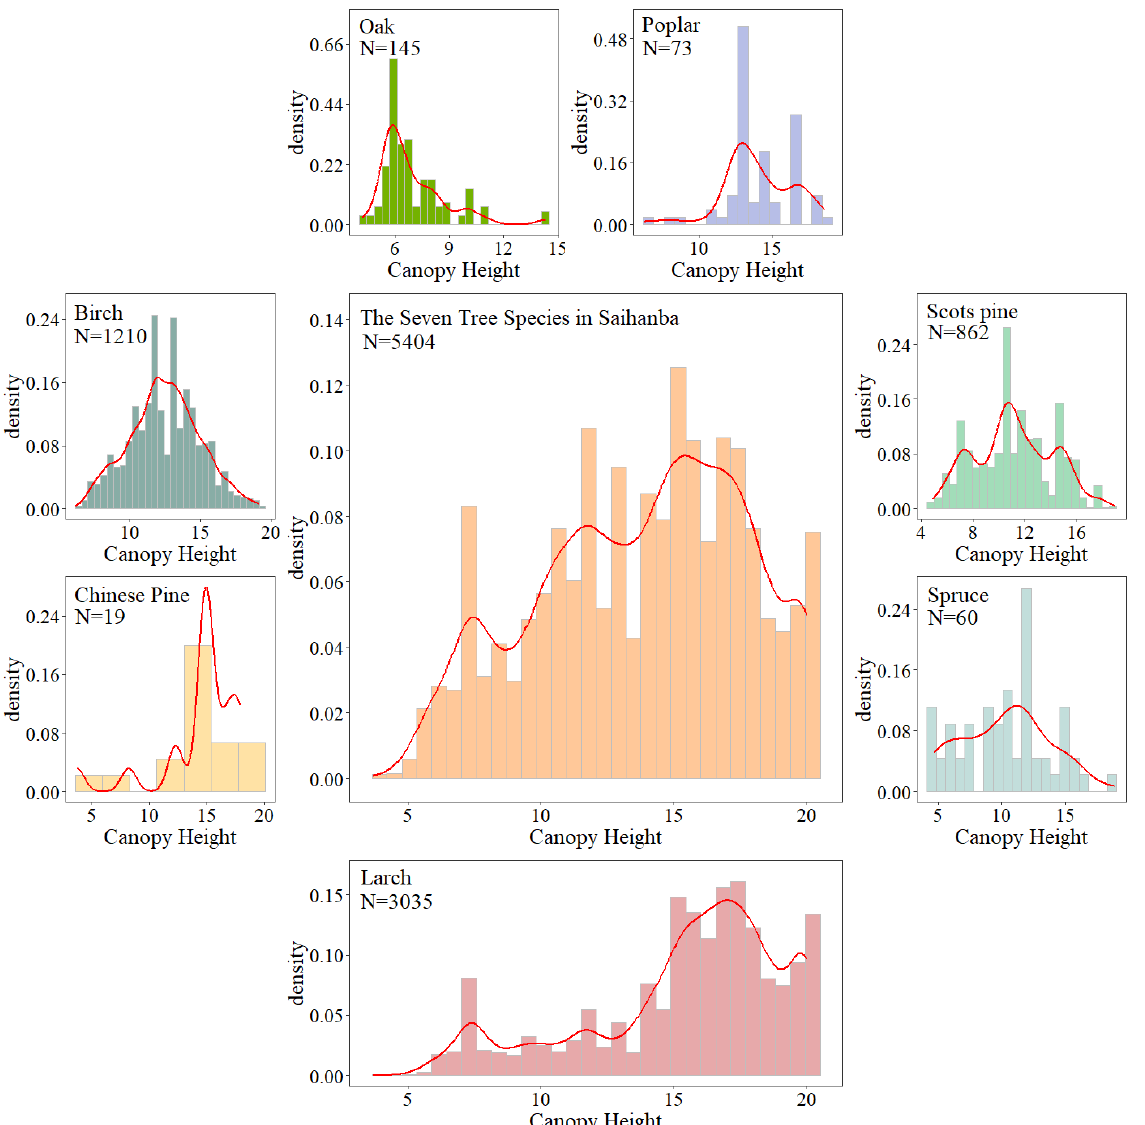
Figure 2. Histogram of tree species from the FMI in the Saihanba forest farm.